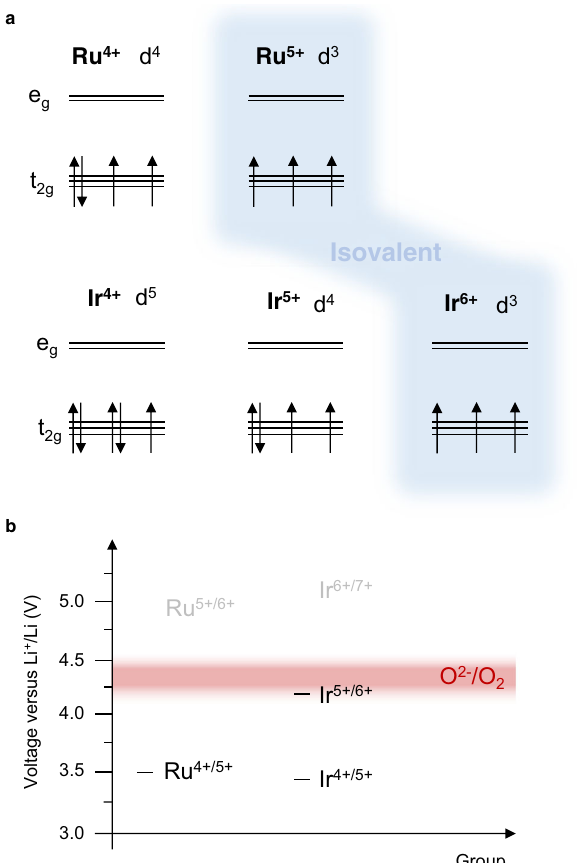
analysis of the electrochemical load curves in Fig. 1 are shown in Fig. 5b. The substitution of Ir for Sn limits the Ir redox capacity increasing the amount of extractable Li available to be charge compensated by O-redox explaining why substantial O oxidation is observed for Li 2 Ir 0.5 Sn 0.5 O 3 . Much like the 3d TM Li-rich O-redox systems, those based on 4d and 5d TM elements exhibit TM migration, loss of honeycomb ordering, O-loss and voltage hysteresis. The vibrational spectra measured by RIXS now also show that molecular O 2 , rather than peroxides or peroxo-like species, are formed in all of these sys- order of the O – O dimer in the bulk of the cathodes. Future structural modi fi cations other than covalency of the host network to improve their performance.